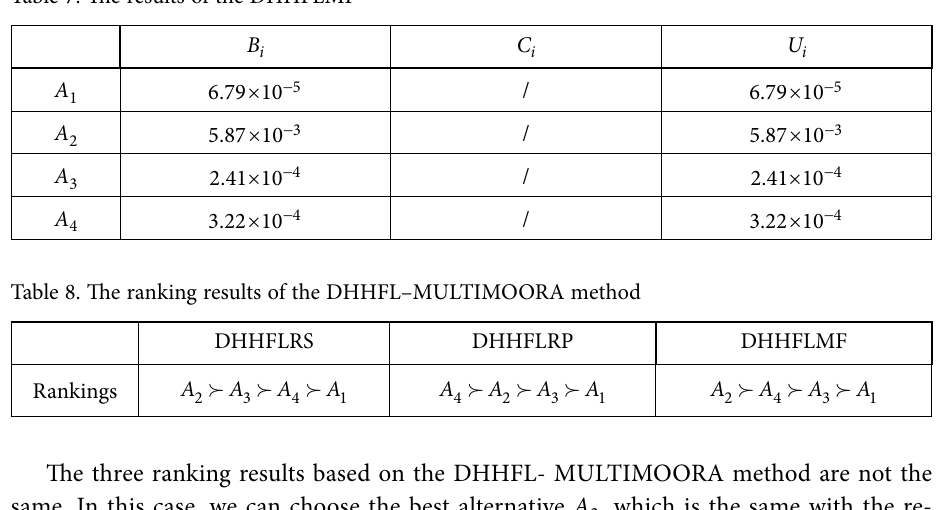
Table 7. The results of the DHHFLMF B i C i U i A 1